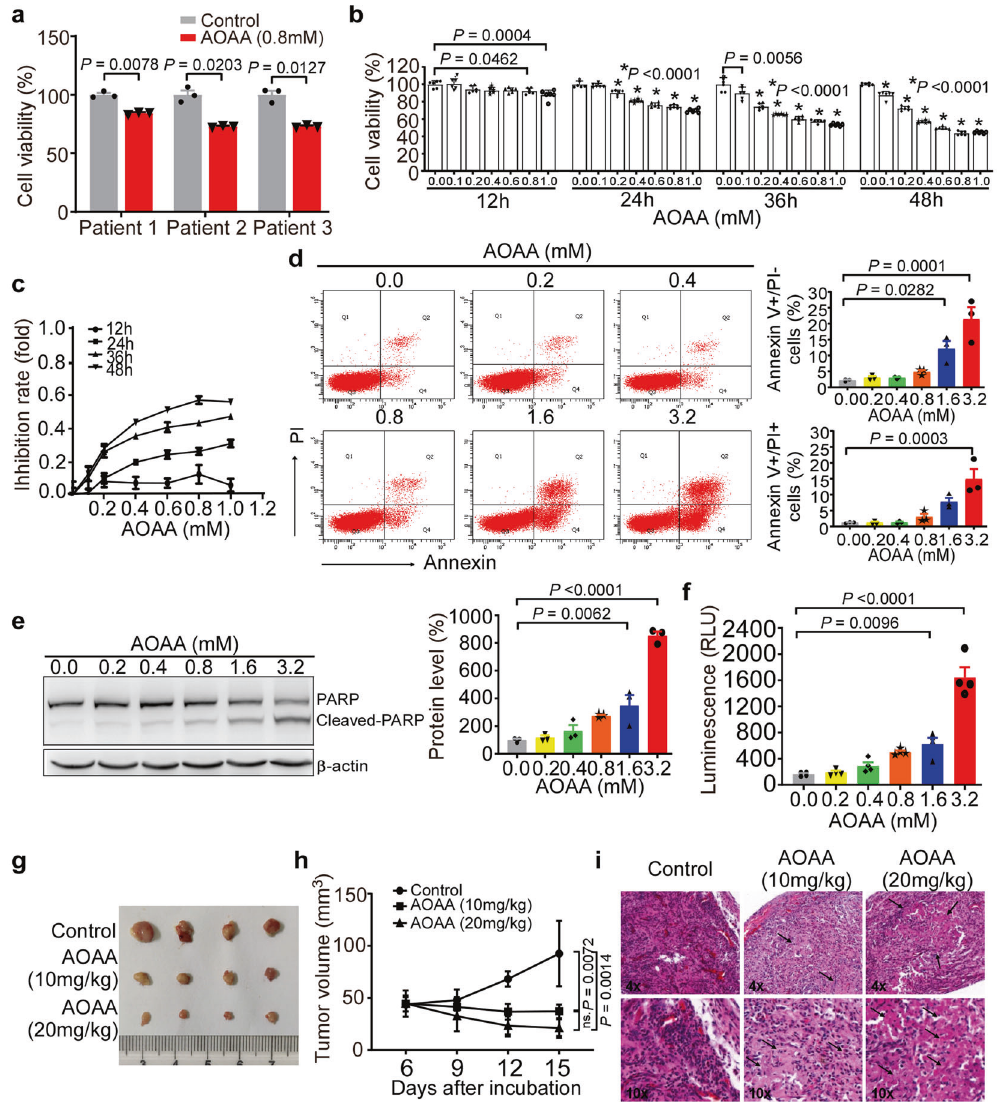
Fig. 2 AOAA treatment induced cell apoptosis and inhibited cell growth. a Peripheral blood mononuclear cells were extracted from three CML patients and treated with AOAA (0.8 mM) for 48 h. Cell viability was detected by MTT assay ( n = 3). b K562 cells were treated with AOAA at different concentrations (0.0, 0.1, 0.2, 0.4, 0.6, 0.8, and 1.0 mM for 12, 24, 36, and 48 h). Cell viability was measured by MTT ( n = 6). c The inhibition rates are shown in the line chart. d K562 cells were treated with AOAA at 0.0, 0.2, 0.4, 0.8, 1.6, and 3.2 mM for 48 h. The cells